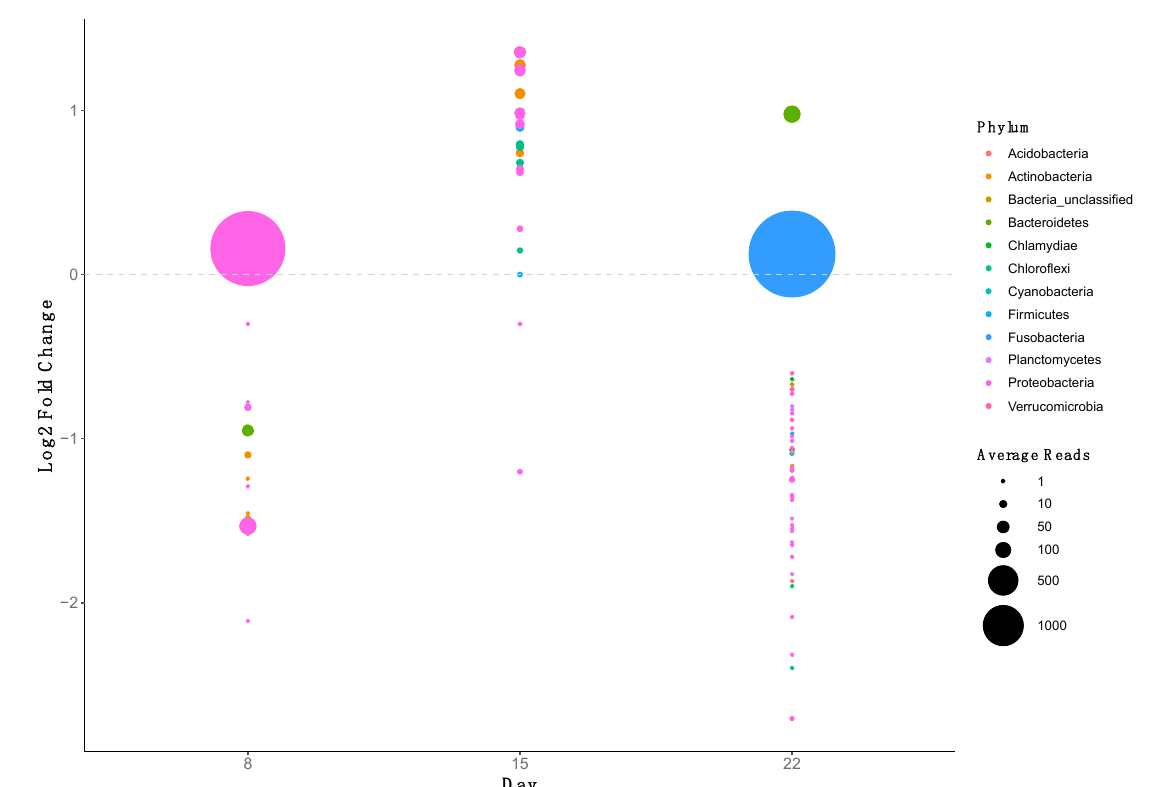
Figure 5. Plot of operational taxonomic units (OTU) that were significantly differentially abundant ( p < 0.05) in the distal gut of Nile tilapia after treatment with oxytetracycline, compared with the control fish. Effect size is represented as the log2 fold-change of each OTU observed in fish from the oxytetracycline diet treatment compared with fish fed the control diet. Each circle represents a single OTU and is coloured according to the phylum to which the OTU originates. The circle size is proportional to the mean read abundance of each